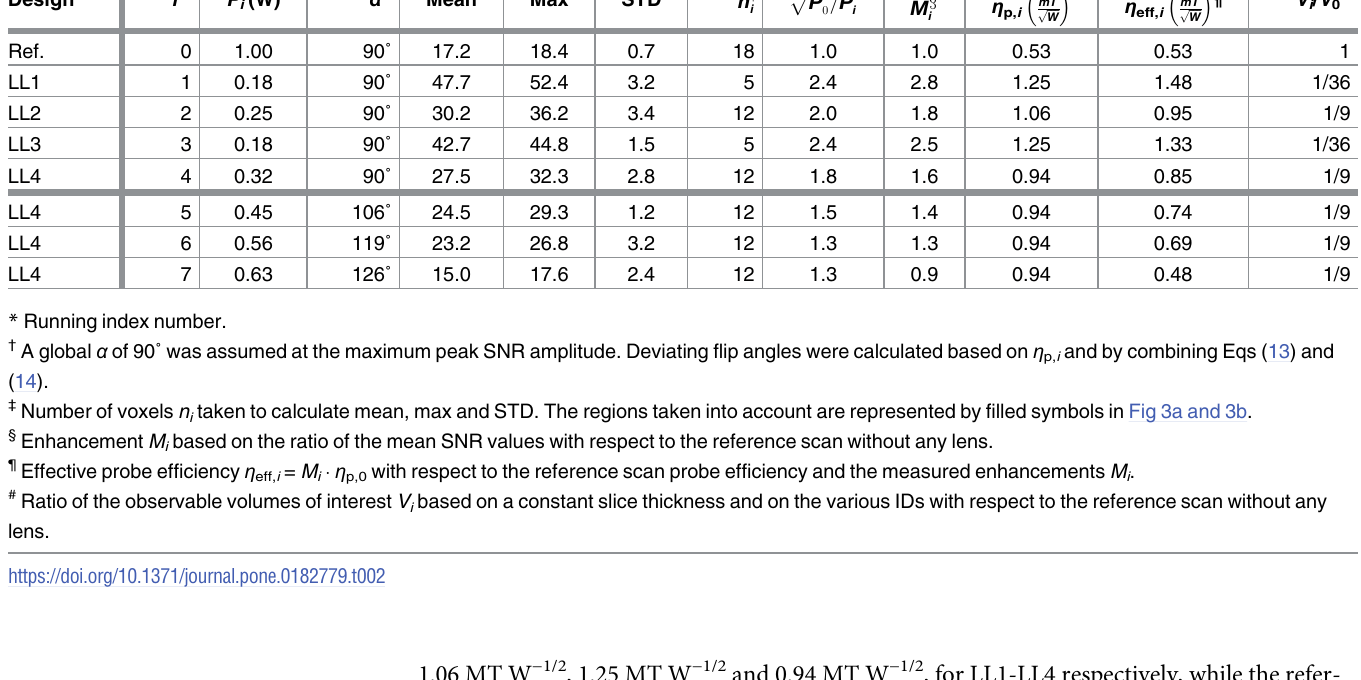
Table 2. Calculated mean, maximum, and standard deviation (STD) of the SNR values from Fig 3a and 3b as well as derived figures of merit.